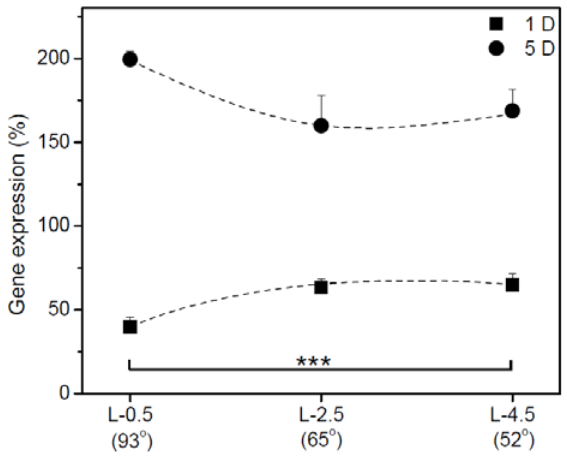
Figure 7. Relative expression of heat shock protein 70 in hADSCs after adhesion on each gradient surface (L-0.5, L-2.5, and L-4.5) on days 1 5. Levels of mRNA were measured with RT-PCR and normalized with β-actin mRNA ( *** p <